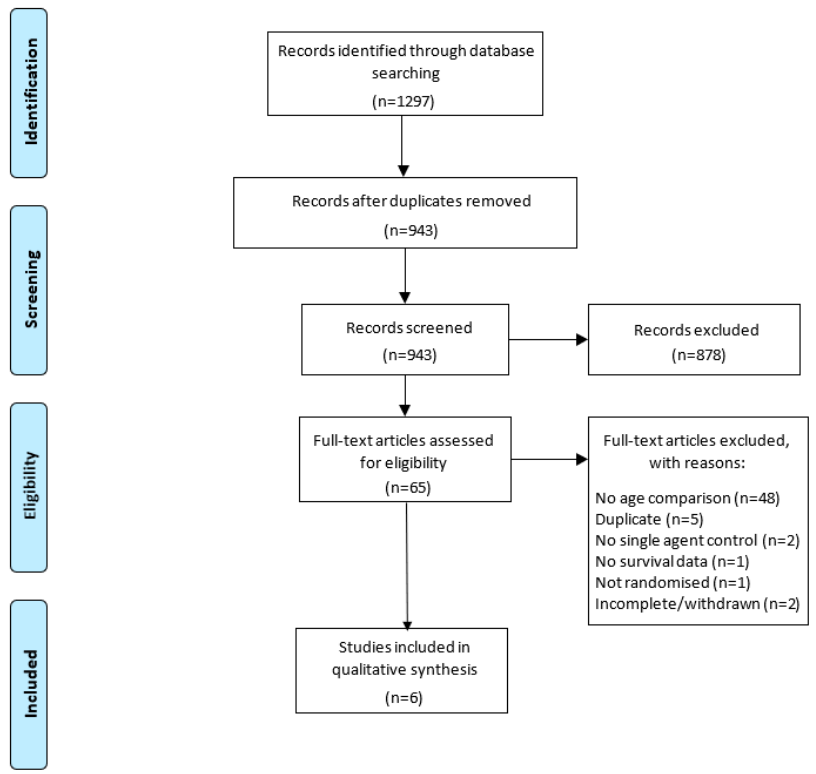
Figure 1. PRISMA fl ow diagram for the screening of articles included in this review [14]. Figure 1. PRISMA flow diagram for the screening of articles included in this review